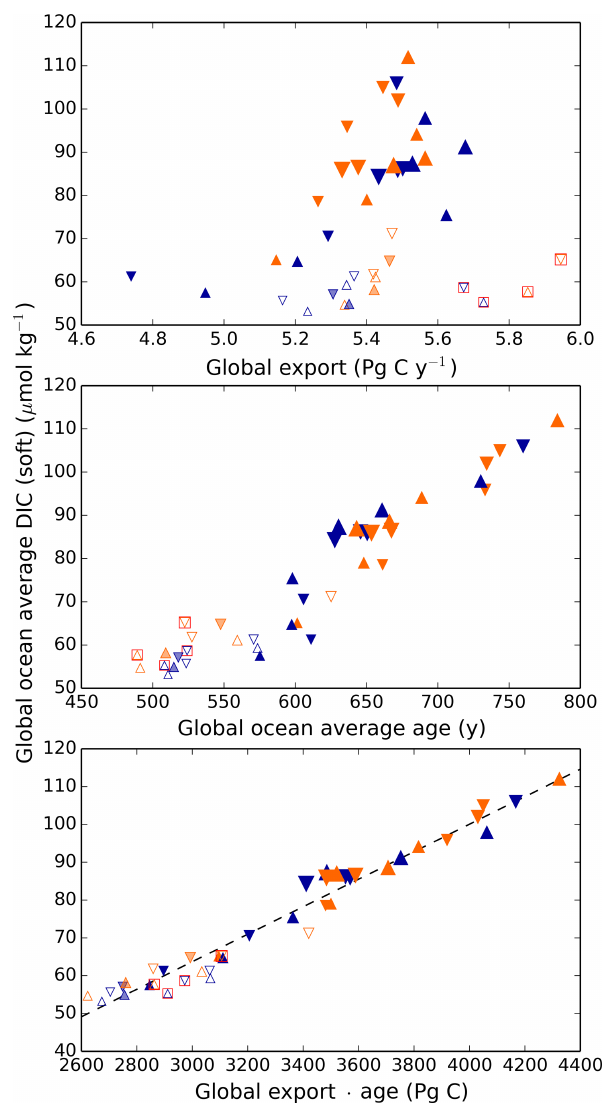
Figure 4. Globally averaged DIC soft vs. global export, ideal age, and age × export. Globally averaged DIC soft can be approximated remarkably well by the global export flux of organic carbon at 100m multiplied by the average age of the ocean. The latter is an ideal age tracer in the model that is set to 0 at the surface and ages by 1 year each model year in the ocean interior. Orange and blue symbols represent high and low obliquity scenarios, respectively; triangles pointing upward and downward represent greater North- ern and Southern hemisphere seasonality (precession 270 and 90 ◦ ); outlines are scenarios with LGM ice sheets; light shading indicates scenarios with LGM ice sheet topography but PI albedo. Red boxes indicate Fe fertilization simulations (runs 37–40). The size of the symbols corresponds to the